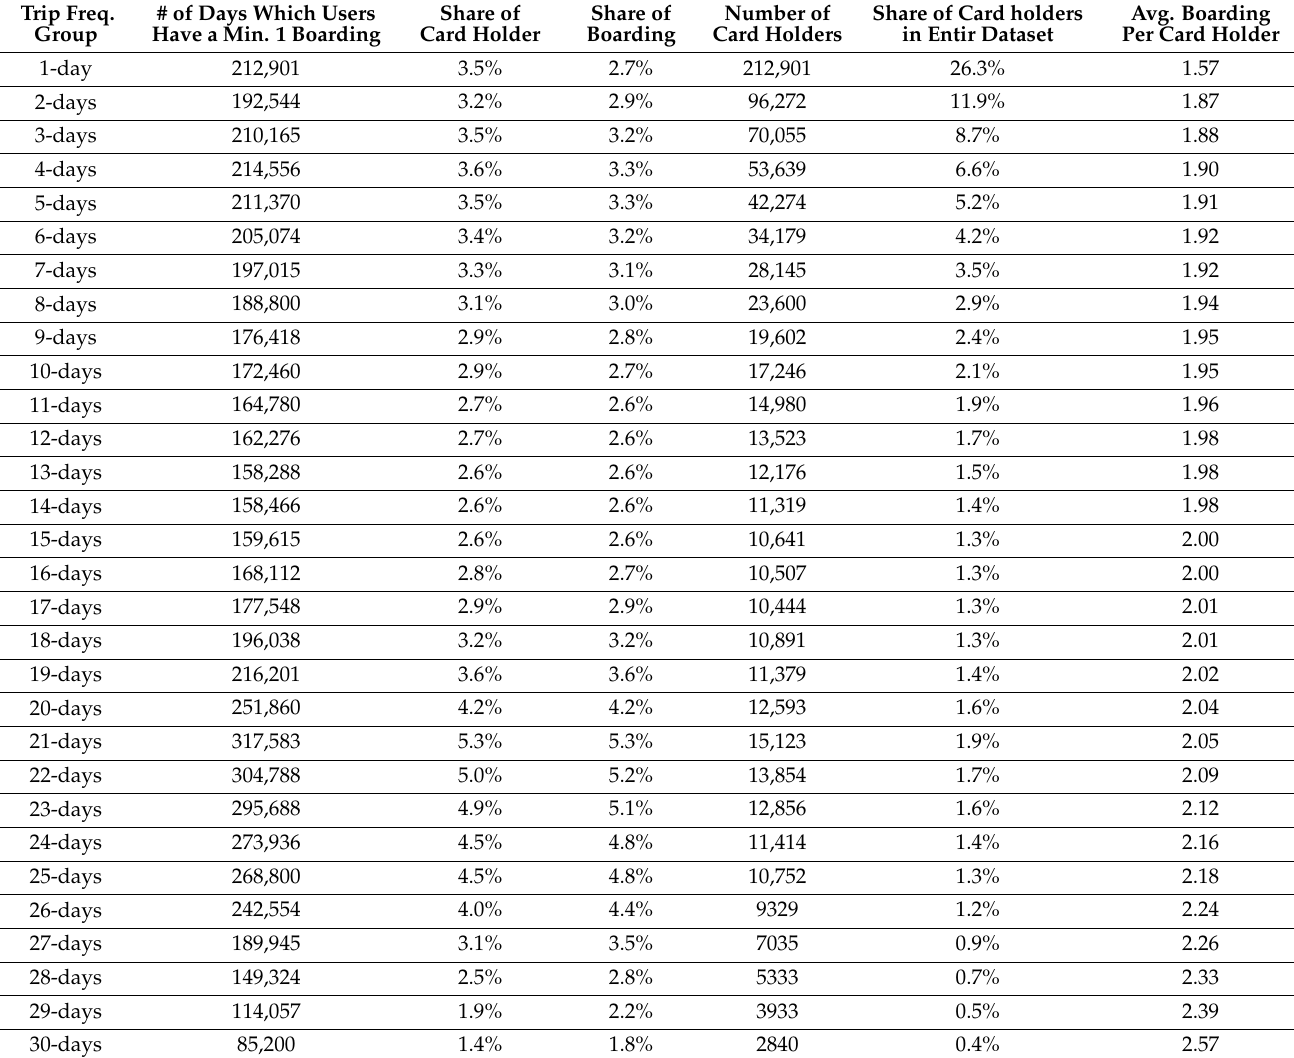
Table A1. Distribution of boarding frequency of public transport (PT) users over 1-month data. Trip Freq.